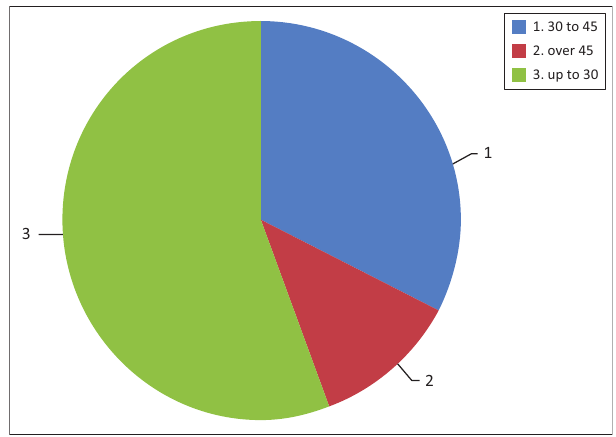
FIGURE 1: Age distribution of the subjects (years).